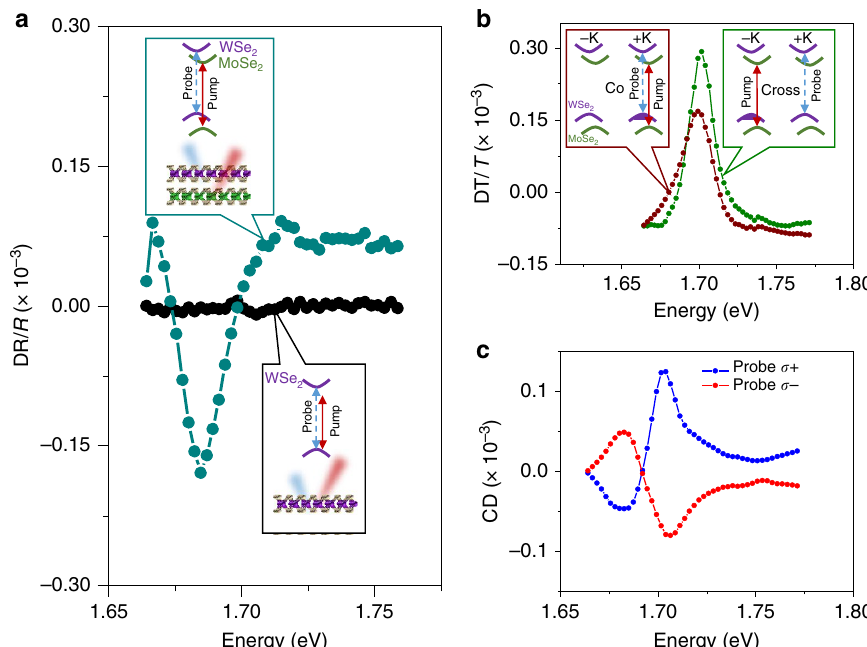
Figure 2 | Interlayer hole spin-valley polarization transfer. ( a ) Non-degenerate DR of a MoSe 2 –WSe 2 heterostructure, and an isolated WSe 2 region on the sample. When pumping on the lower energy MoSe 2 exciton resonance (1.621eV), there is a strong DR response corresponding to the WSe 2 exciton (dark cyan), whereas the isolated WSe 2 monolayer shows negligible DR response (black). Co-circularly polarized pump and probe is shown. The insets depict the pump-probe scheme. The pump is shown as a solid red line, and the probe is the dashed blue line. DR data were measured at 50K. ( b ) Co- (burgundy) and cross- (green) circularly polarized DT spectra of the WSe 2 exciton resonances, when pumping the low-energy MoSe 2 exciton resonance at 1.621eV. The insets show the pump and probe scheme, where the band filling of the WSe 2 valence is shown. The line shapes are discussed in the text. ( c ) Pump-induced CD of the WSe 2 exciton resonances when pumping MoSe 2 at 1.621eV. CD highlights the differences between co- and cross-polarized DT responses. As expected, the sign of the CD response flips with probe (or pump)